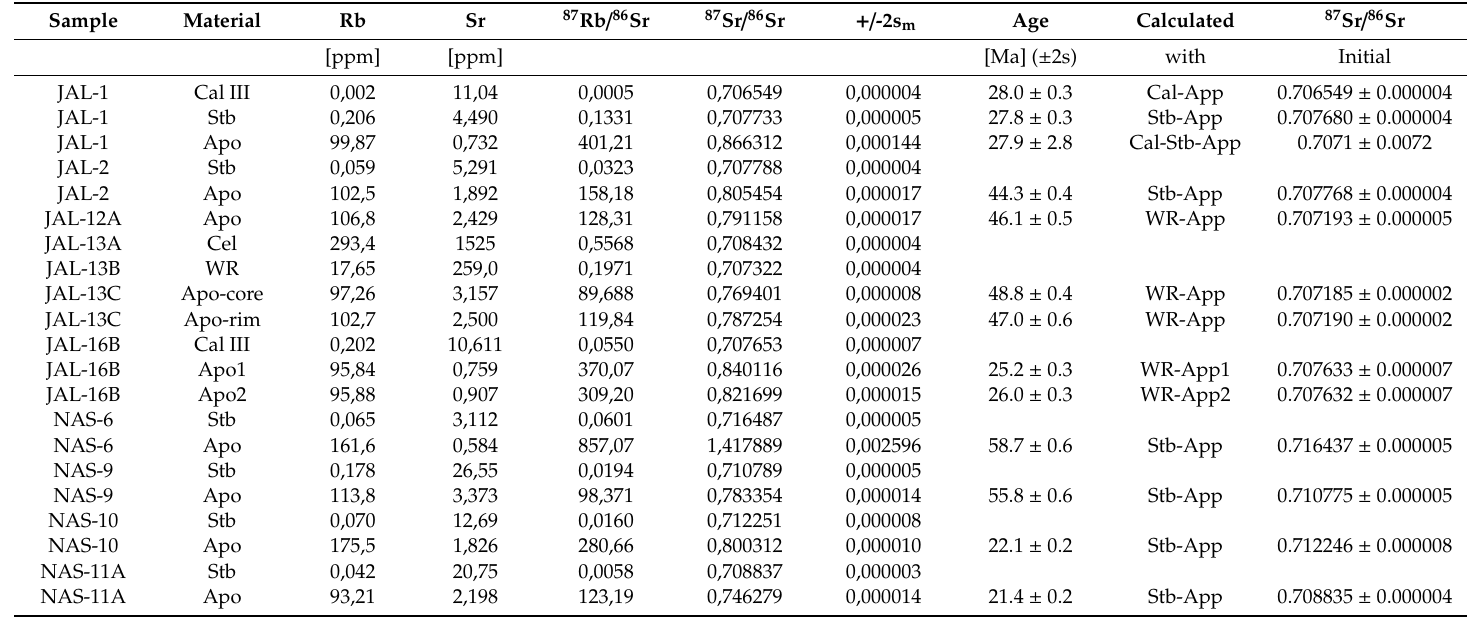
Table 9. Rb-Sr isotopic data on whole rock (WR), calcite (Cal), stilbite (Stb), apophyllite (Apo), and celadonite (Cel) from Savda and Nashik (DVP, India). Rb-Sr ages are calculated from apophyllite and corresponding calcite, stilbite, or whole rock, assuming an error of ± 1% on the 87 Rb / 86 Sr ratio.